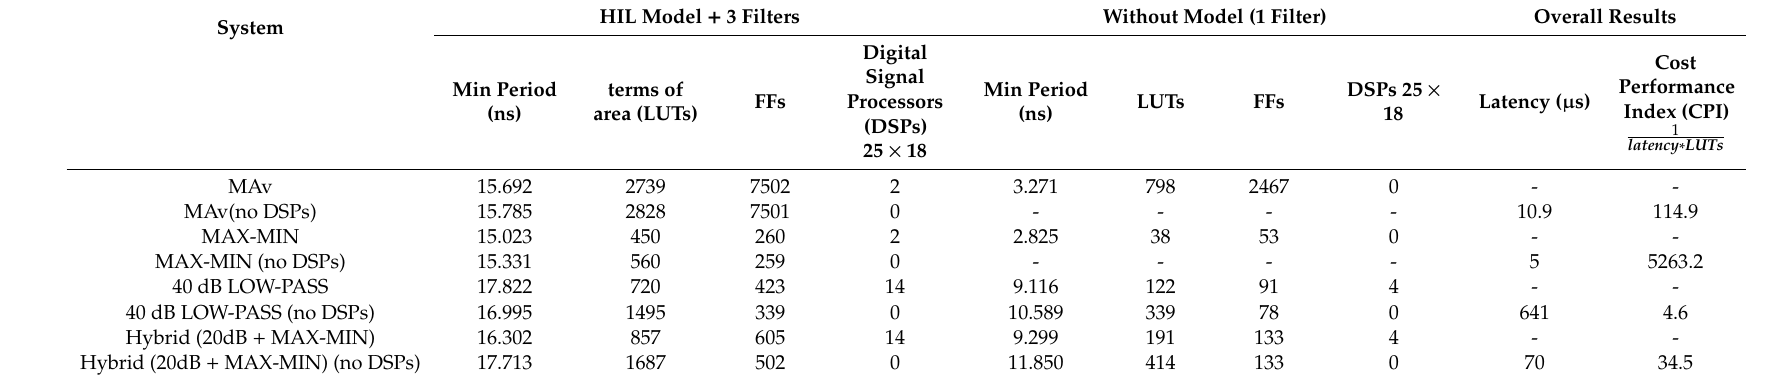
Table 2. Comparison of used field programmable gate array (FPGA)